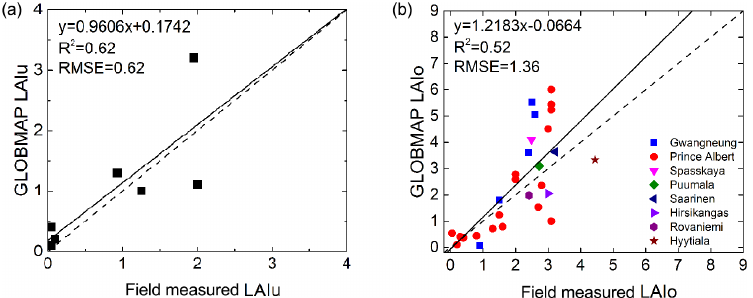
Figure 9. Comparison of the GLOBMAP LAI u (LAI o ) and ground LAI data: (a) results for understory LAI at Prince Albert National Park, Canada ( N = 7); (b) results for overstory LAI ( N =